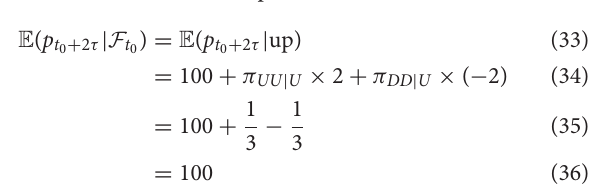
same calculation two time-steps